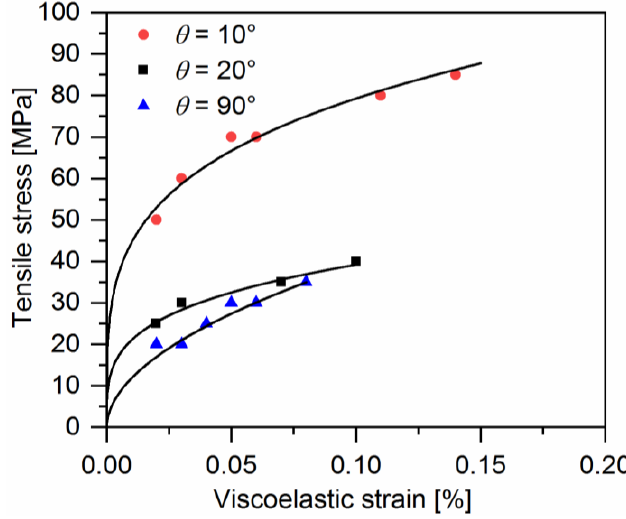
Figure 11. Experimental data of axial stress-viscoelastic strain of a quasi-UD E-glass/polypropylene composite subjected to off-axis tensile loading.